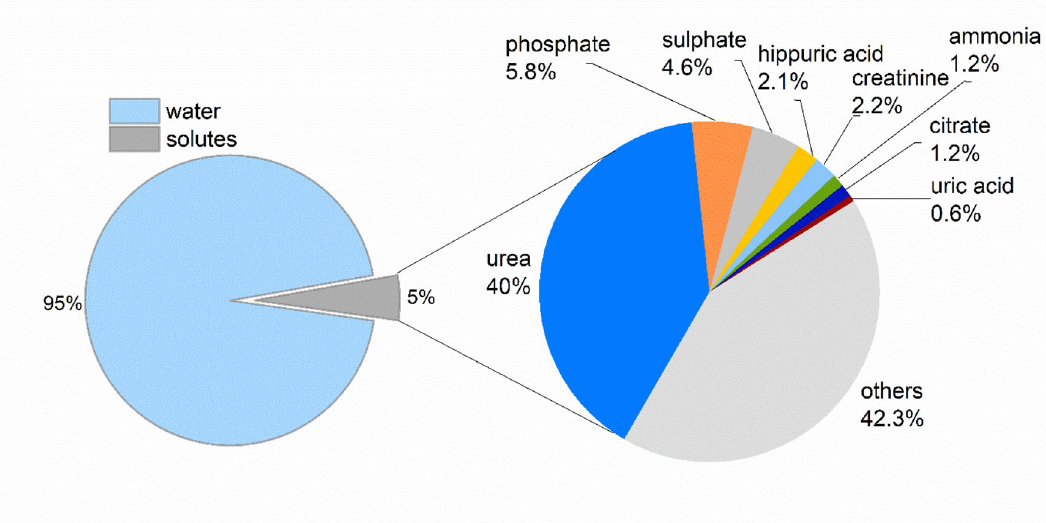
Figure 1. The composition of human urine. The percentages reflect the mass ratio of each urine component with respect to the total mass of 1.5 L-urine. The others (42.3%) represent hundreds of different molecules, each contributing less than 0.5% to the total urine composition in the same chart 32–34